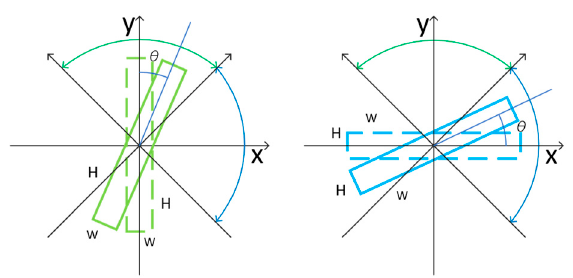
Figure 2. Redefinition of the bounding box to decouple an oriented bounding box (OBB) as a horizontal bounding box (HBB h/v ) and the acute angle between HBB and OBB. The dashed boxes represent the HBB corresponding to the OBB (the solid boxes).